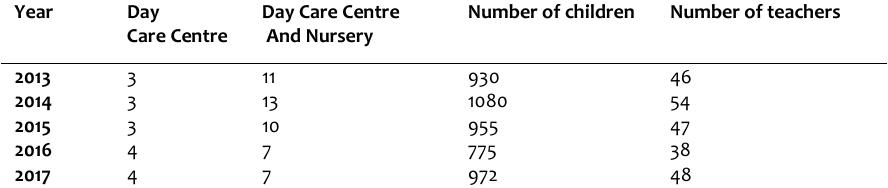
Table 2. Number of Day Care Centres and Nurseries, and